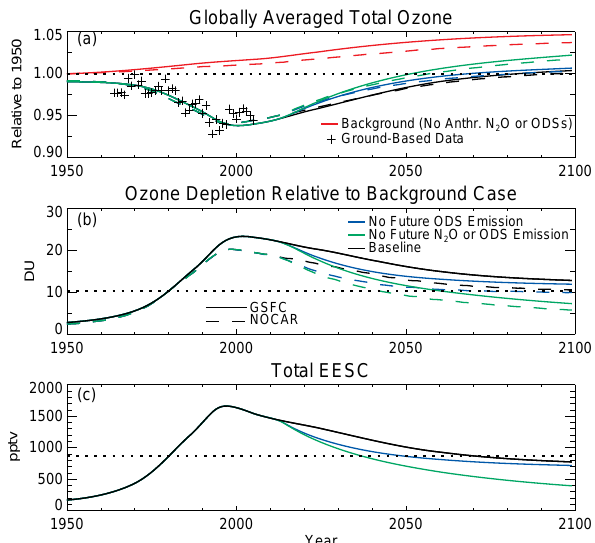
Fig. 2. (a) Globally averaged total column ozone, (b) ozone de- pletion relative to a case in which no anthropogenic N 2 O or ODSs were or will be emitted (“background” case), and (c) anthropogenic EESC time series including ODS and N 2 O contributions (calcu- lated assuming an age spectrum with a 3.0y mean age, 1.5y width). Cases shown are the baseline scenario (black), in which future ODS emissions follow a path consistent with current growth and Mon- treal Protocol controls and IPCC scenario A1B for N 2 O, CH 4 , and CO 2 ; a case in which no anthropogenic ODSs are emitted after 2010 (blue); and a case in which no anthropogenic ODSs or N 2 O is emitted after 2010 (green). The ozone time series for the back- ground case is also shown (red). Solid lines are calculations from the GSFC model; dashed are for the NOCAR model. “+” symbols represent ground-based total ozone data (WMO, 2007) normalized so the 1964–1980 average agrees with the model calculations. The dotted lines represent the 1980 benchmark levels; 1980 values are used in previous ozone assessments and are also often considered in Montreal Protocol discussions. In panel (b), the NOCAR ozone depletion is increased by 3% so the depletion in 1980 is identical for the two models. For example, this leads to an apparent maximum depletion relative to the background case in the NOCAR model of 20.3 DU rather than the actual